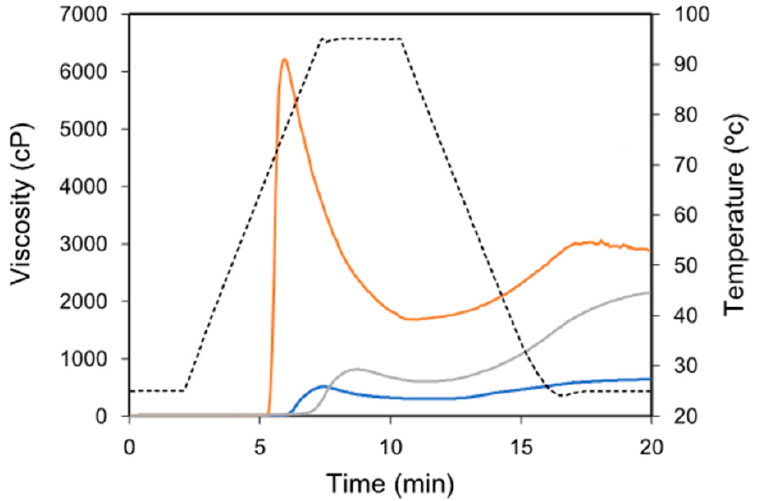
Figure 1. RVA profiles in starch from the different sources: potato (orange line), wheat (grey line) and waxy maize (blue line). Dotted line represents the temperature profile used during analysis.